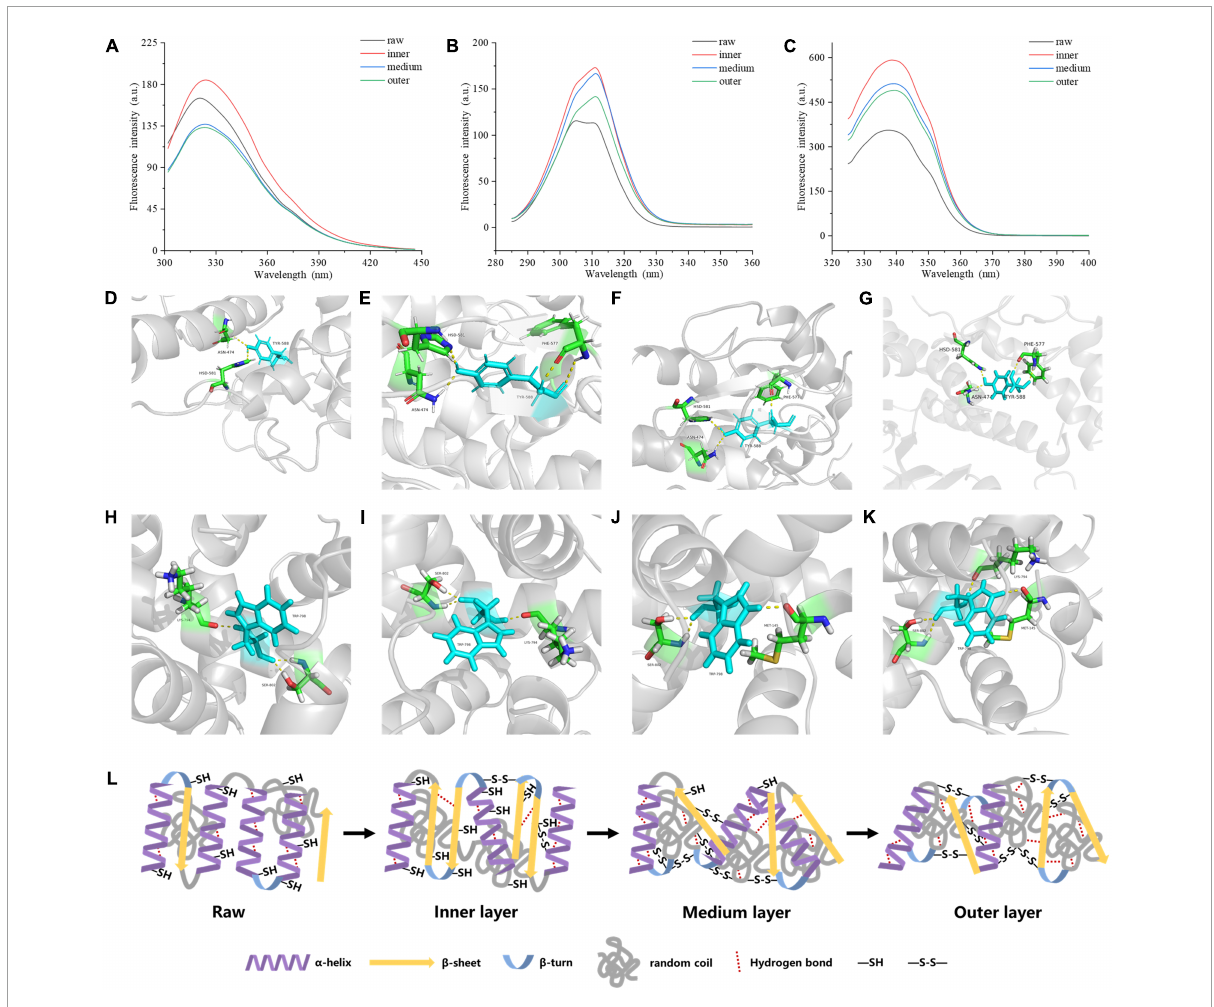
FIGURE4 Tertiary structure of MP samples from different doneness layers: (A) Endogenous fluorescence spectra; (B) synchronous fluorescence spectra for Tyr residues ( (cid:49) λ = 20 nm); (C) synchronous fluorescence spectra for Trp residues ( (cid:49) λ = 60 nm). Hydrogen bonds between myosin aromatic amino and the surrounding amino acids treated with raw (D,H) , inner layer (E,I) , medium layer (F,J) , and outer layer (G,K) , respectively. (L) Mechanistic diagram of MP secondary structure, hydrogen bond and disulfide bond changes of different doneness